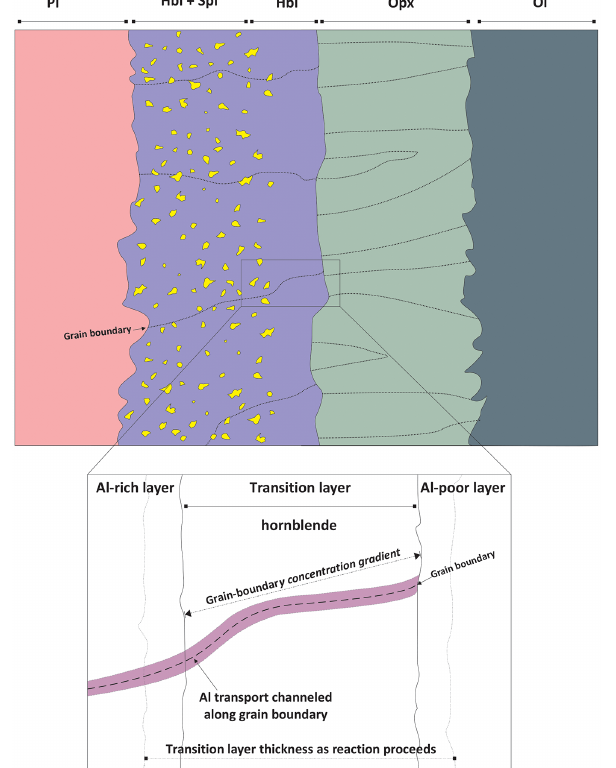
Figure 13. Sketch of a typical corona developed between plagio- clase and olivine in metagabbros (after Ashworth, 1993). As reac- tion proceeds, layers grow by diffusion along grain boundaries of requisite components down concentration gradients to layer bound- aries where they are consumed in the production of product phases. Al is considered to be the most immobile diffusing species, since Al concentration gradients are most marked. Al exerts the greatest control on segregation of corona products in bands, from the most Al-rich symplectite adjacent to plagioclase to Al-poor orthopyrox- ene adjacent to olivine.